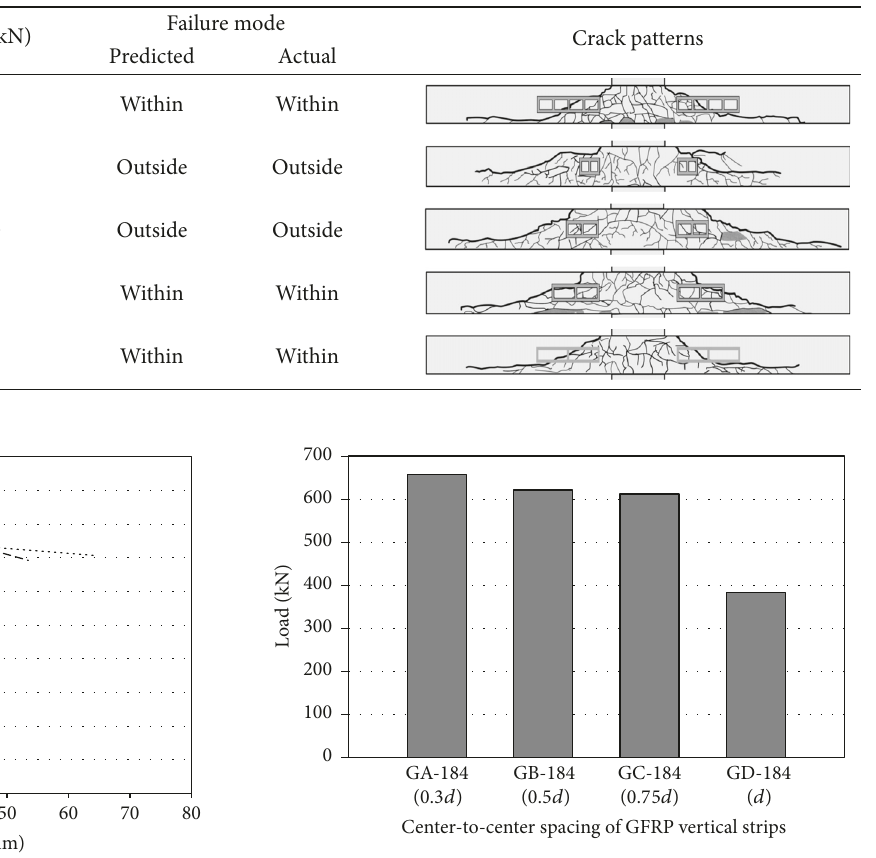
Figure 13: Shear strength depending on the spacing of GFRP vertical